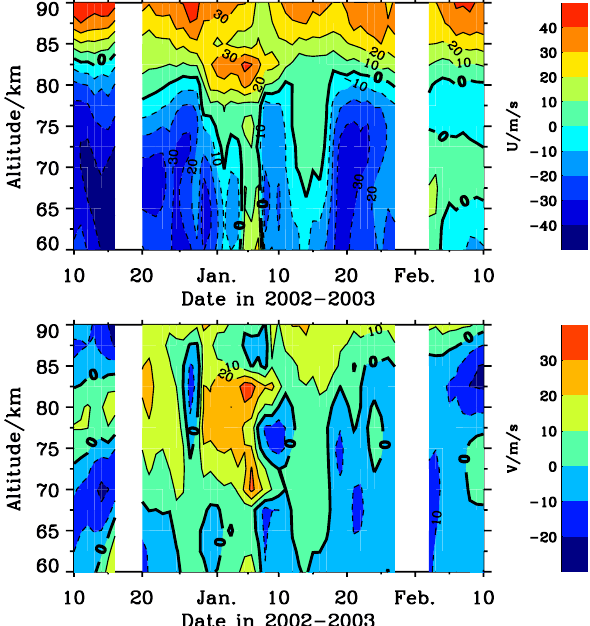
Fig. 5. Background zonal (upper, eastward positive) and meridional (bottom, northward positive) wind from UARS/HRDI observations. Blank denotes unavailable